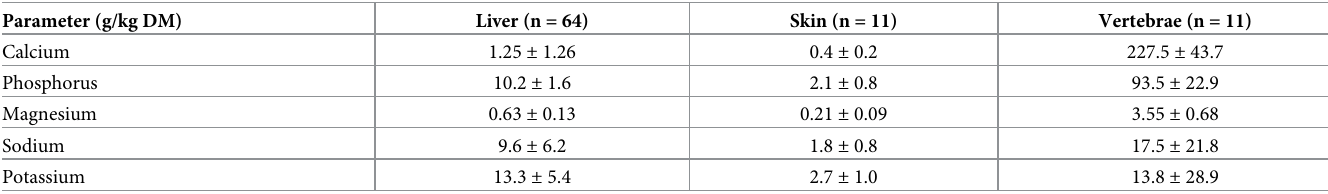
Table 5. Mineral contents (g/kg DM) in different body parts of snakes (means ± SD; n = number of samples). Parameter (g/kg